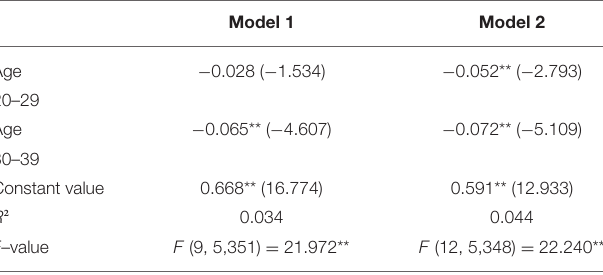
TABLE 6 | Robust standard error regression method for different age